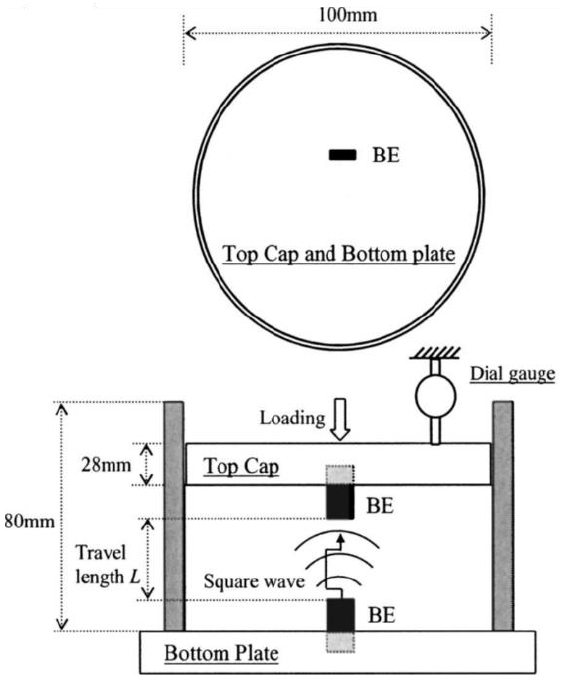
Figure 19. Odometer cell where bender elements are mounted in top cap and bottom plate (after [69], with permission from 2021 ASCE).